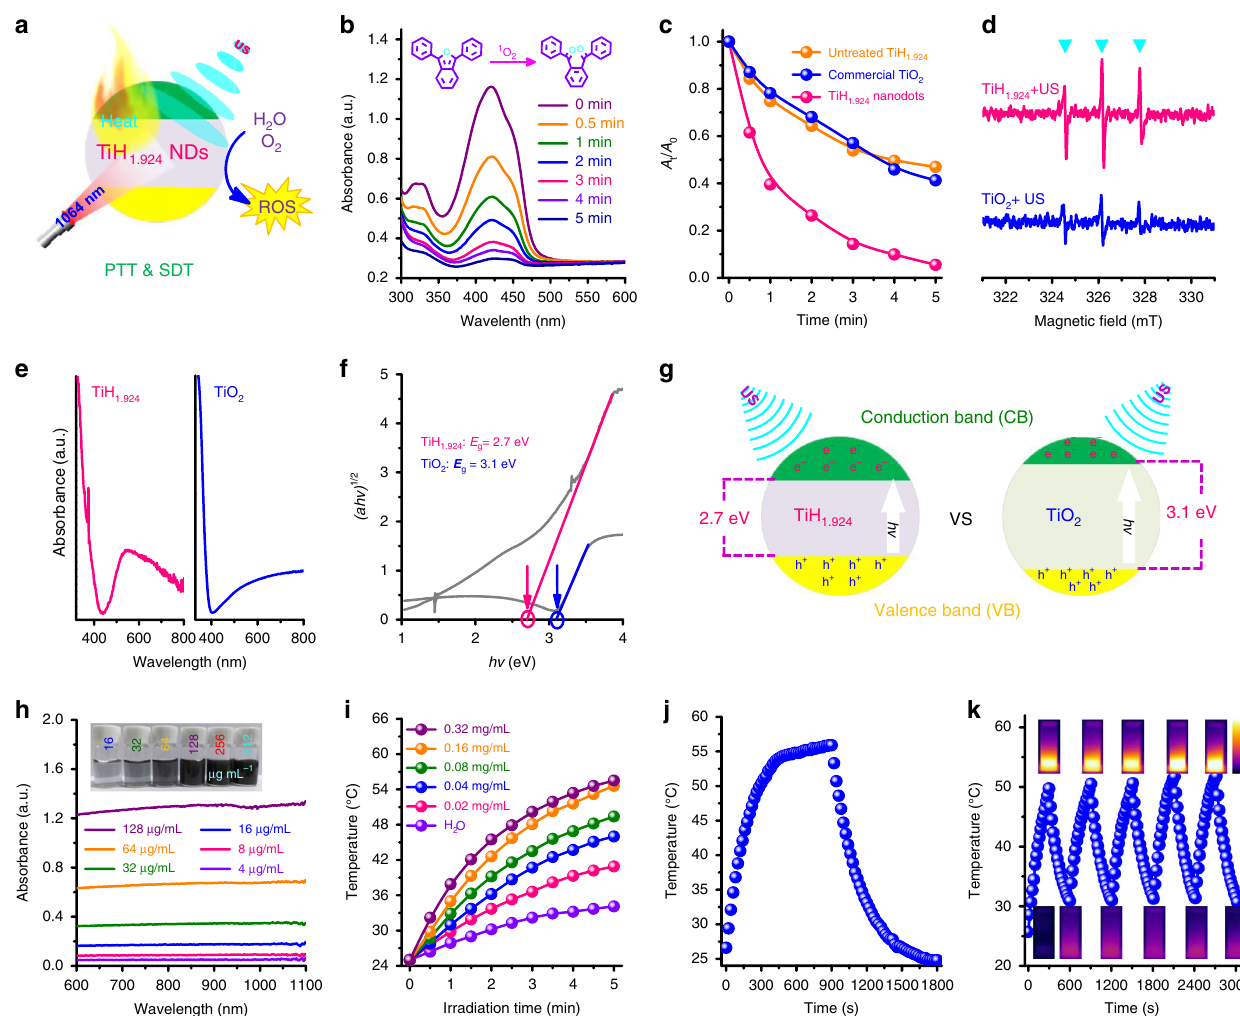
Fig. 3 Sonodynamic and photothermal performance of TiH 1.924 nanodots. a Schematic illustration of sonodynamic and photothermal properties of TiH 1.924 nanodots. b Time-dependent oxidation of DPBF indicating ROS generation by US-activated TiH 1.924 nanodots. c Comparison of DPBF oxidation by TiH 1.924 nanodots, untreated TiH 1.924 , and commercial TiO 2 under US irradiation for 5 min. d ESR spectra demonstrating ROS ( 1 O 2 ) generation for TiH 1.924 and TiO 2 under US irradiation for 1 min. e , f Normalized absorption spectra ( e ) and optical bandgaps ( f ) of TiH 1.924 nanodots and TiO 2 . g Schematic illustration of the activation mechanism of TiH 1.924 and TiO 2 under US irradiation. h UV-vis-NIR absorbance spectra at different concentrations of TiH 1.924 nanodots (4, 8, 16, 32, 64, and 128 µ g mL − 1 ). The inset is the photograph of TiH 1.924 nanodots with different concentrations. i Concentration-dependent photothermal heating curves of TiH 1.924 nanodots (0, 0.02, 0.04, 0.08, 0.16, and 0.32 mg mL − 1 ). j The photothermal pro fi le after laser exposure to reach a steady temperature and then to cool down by turning the laser off. k Heating/cooling pro fi les for fi ve repeated ON-OFF cycles of laser